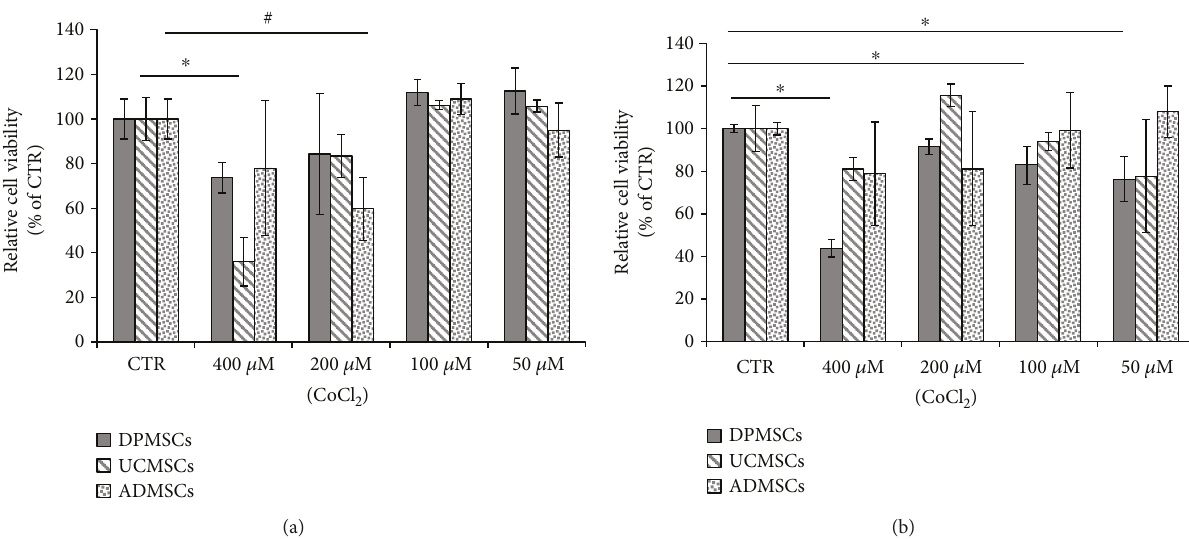
Figure 1: E ff ects of di ff erent concentration of CoCl on the DPMSCs, UCMSCs, and ADMSCs. (a) Cells treated for 24 h; (b) cells treated for 2 48h. Cell viability was determined by MTT assay and the results were expressed as relative cell viability compared to each control sample. Each value is the mean ± SD of triplicate independent experiments. ∗ p < 0 05 , as compared to control DPMSCs; # p < 0 05 , as compared to control UCMSCs; § p < 0 05 , as compared to control